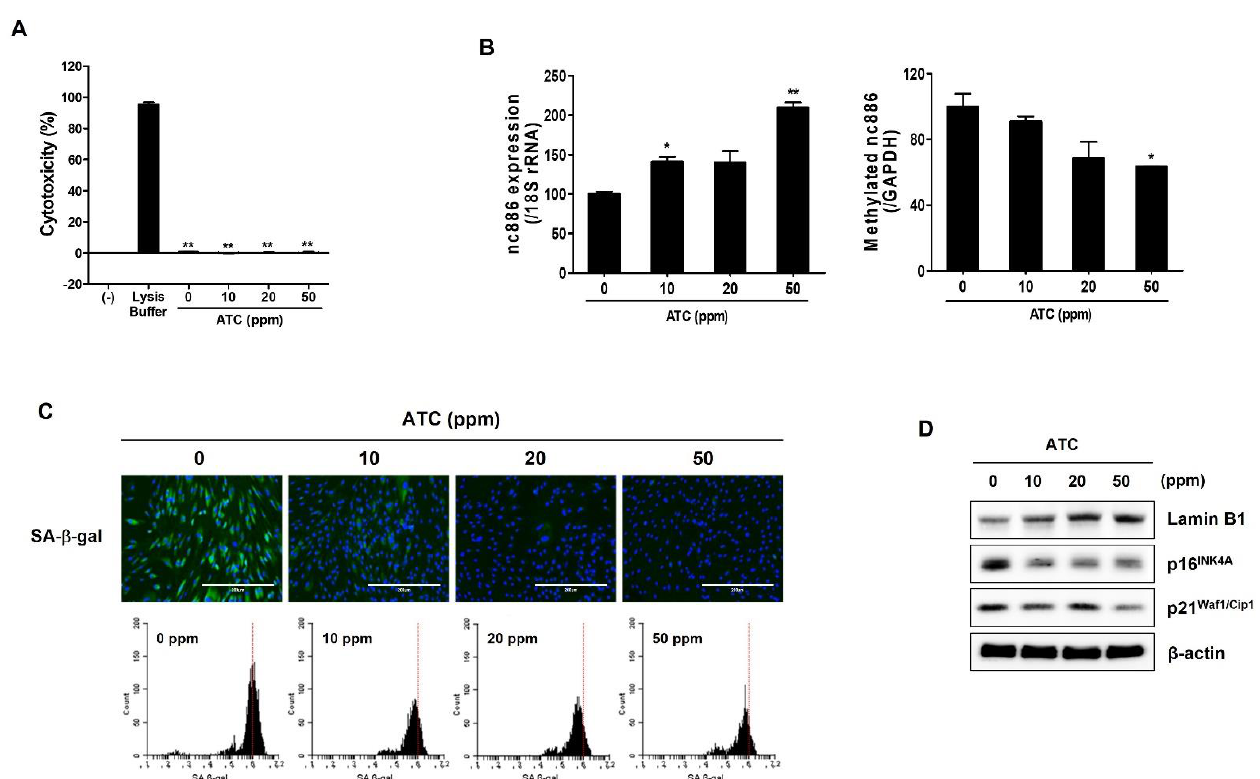
Figure 3. ATC increases nc886 expression in senescent fibroblasts. ( A ) Cytotoxicity was determined by LDH assay after treatment with ATC for 48 h. ( B ) Expression of nc886 was increased by treatment with ATC for 48 h in a concentration- dependent manner (0, 10, 20, 50 ppm). Cells were treated with previously described concentration of ATC and methylation of nc886 was confirmed. ( C ) Expression of SA-β-gal was confirmed in treated senescent fibroblasts via fluorescence microscopy and flow cytometry. ( D ) Expression of senescence markers. Scale bars: 200 μm. Data are presented as mean ± SD of three independent assays. *, p < 0.05; **, p < 0.01 compared to control.